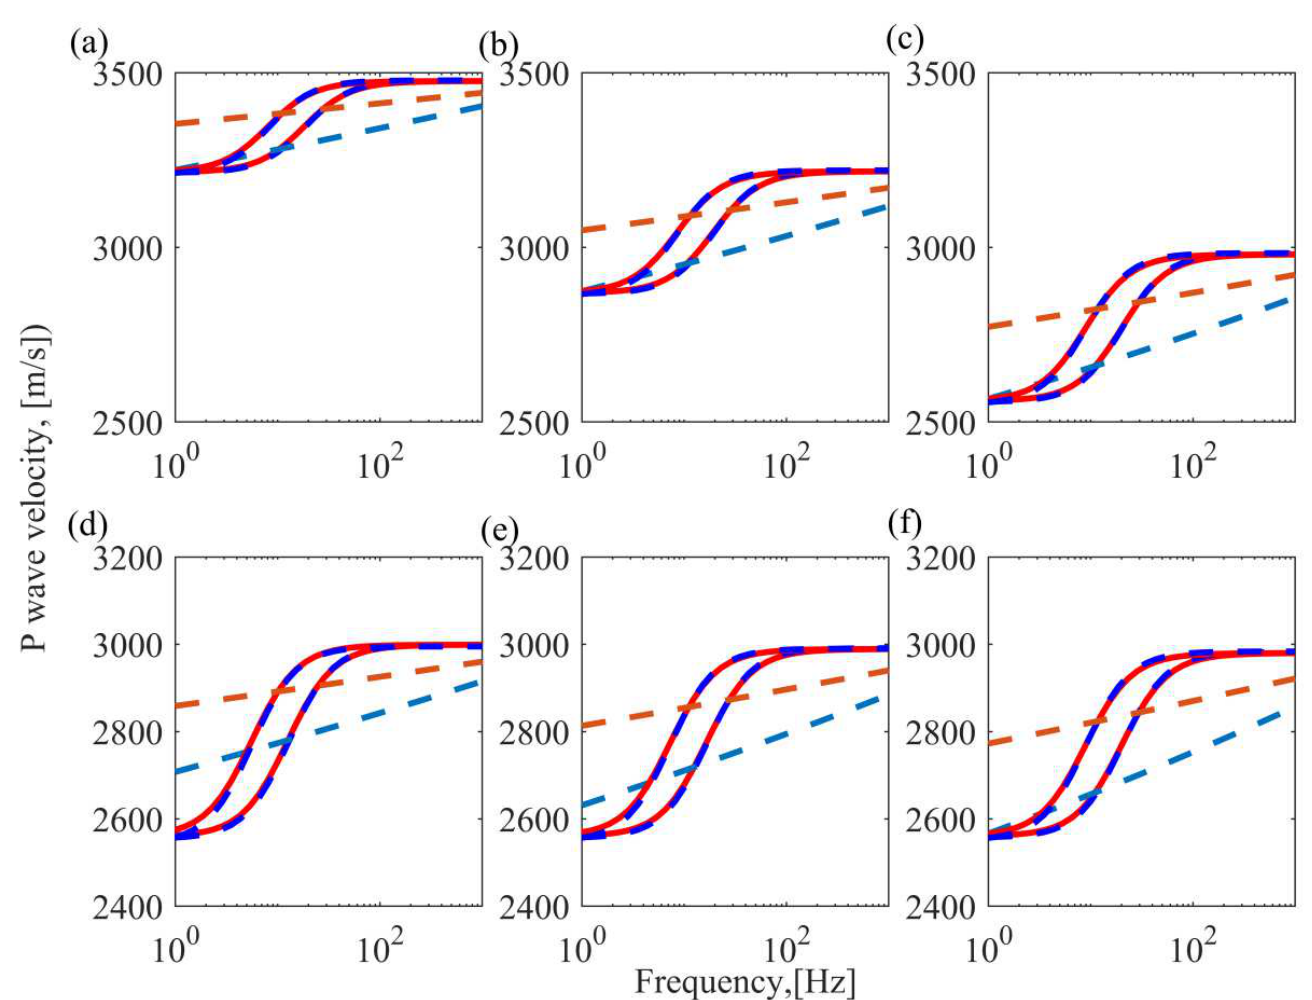
Figure 3. Comparison of velocity dispersion calculated by using the pore fluid dissolution model, the SLS model and the constant Q model. ( a ) Porosity 0.04 and gas saturation 0.25%, ( b ) Porosity 0.06 and gas saturation 0.25%, ( c ) Porosity 0.08 and gas saturation 0.25%, ( d ) Porosity 0.08 and gas saturation 0.15%, ( e ) Porosity 0.08 and gas saturation 0.2%, ( f ) Porosity 0.08 and gas saturation 0.25%. The two red solid curves are the results from the pore fluid dissolution model, the dash blue curves are from the SLS model, and the other dash curves (orange curve and cyan curve) are from the constant Q model. The two red solid curves are the results from the pore fluid dissolution model, where the bubble radius are 4 × 10 − 6 and 6 × 10 − 6 , respectively. The dash blue curves are from the SLS model. The other dash curves (orange curve and cyan curve) are from the constant Q model, and the Q values are picked from the pore fluid dissolution model at 100 Hz. The corresponding 1/Q curves are compared in Figure 4. The two curves in each subfigure represent different bubble radii. As porosity increases, the attenuation becomes larger, while the gas saturation increase influences little about the